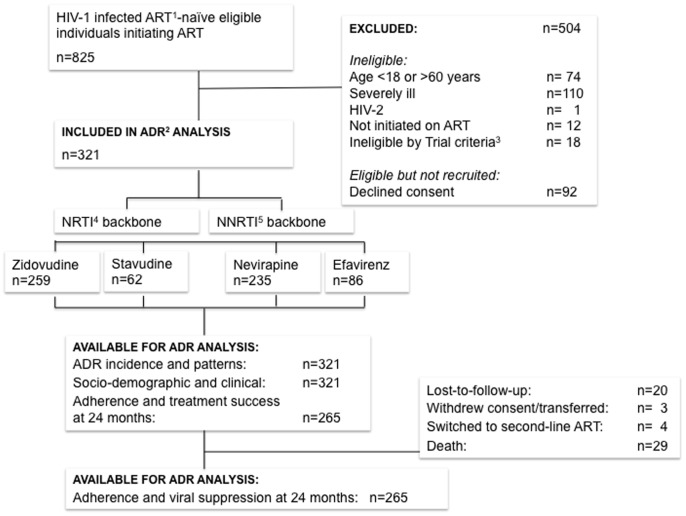
Recruitment flowchart and study outcomes.
1ART: Anti- Retroviral Treatment. 2ADR: Adverse Drug Reaction. 3Trial exclusion criteria: Participant in same household, no available phone network. 4NRTI: Nucleoside Reverse Transcription Inhibitor. 5NNRTI: Non-Nucleoside Reverse Transcription Inhibitor.